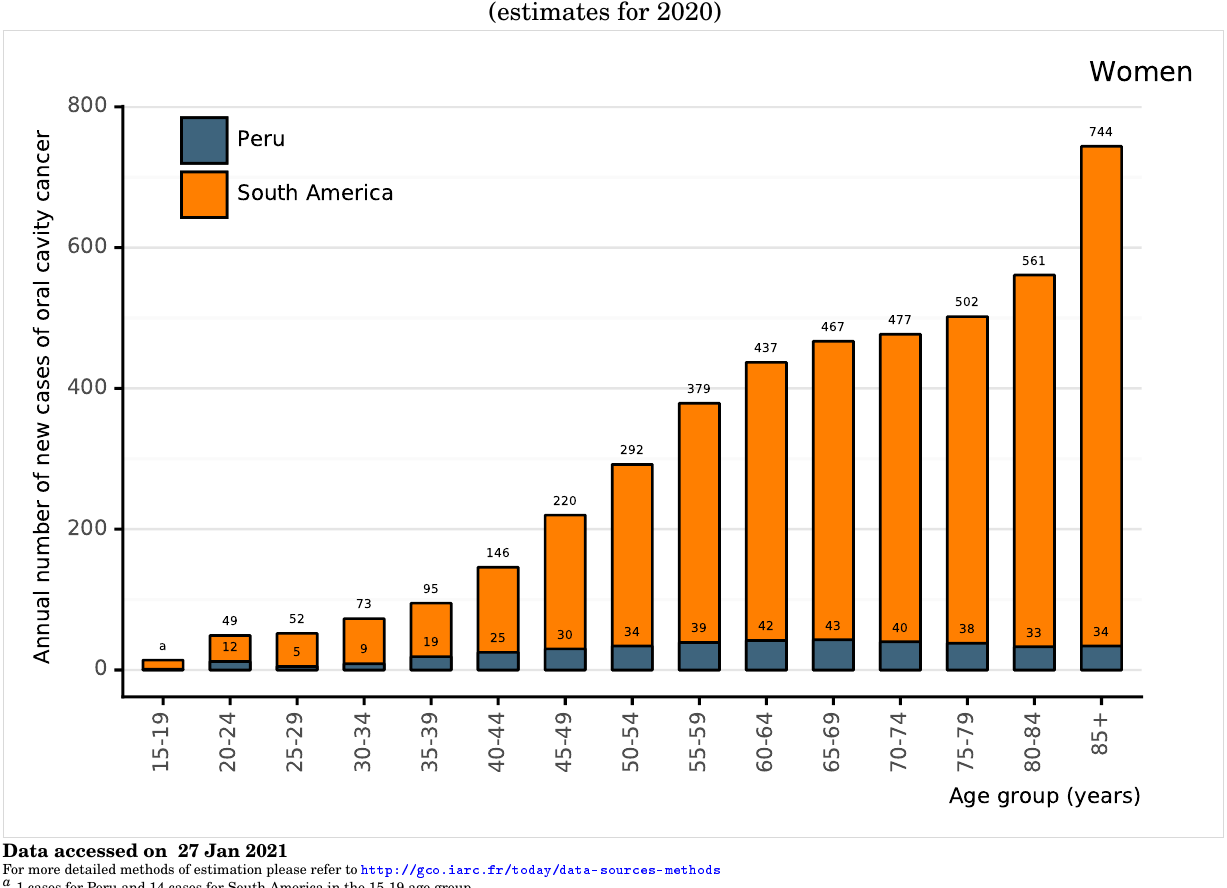
Figure 97: Annual number of new cases of oral cavity cancer among women by age group in